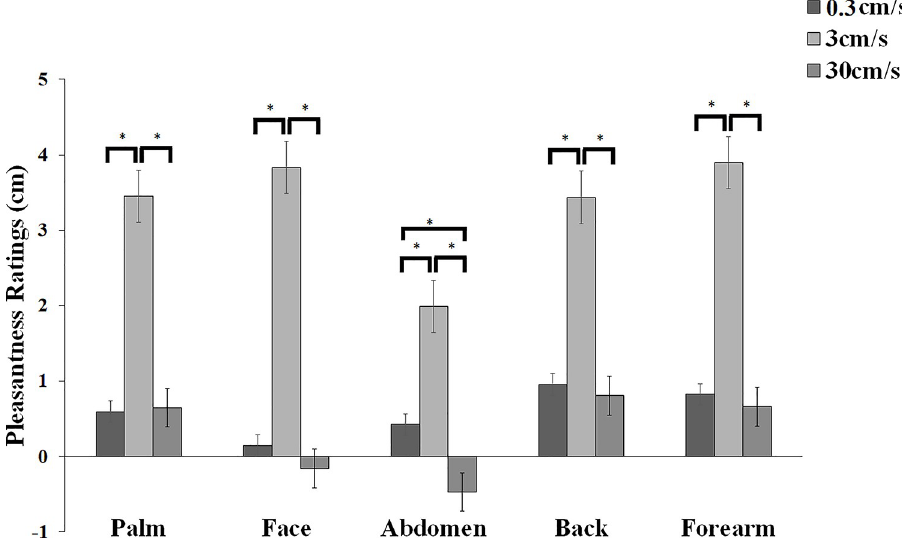
Fig 2. Mean pleasantness ratings (+/- s.e.m) for touch delivered at each of five body sites (palm, face (cheek), abdomen, back, forearm) at 3 cm/s (CT-optimal stroking) and 0.3 cm/s and 30 cm/s (non-CT optimal stroking)